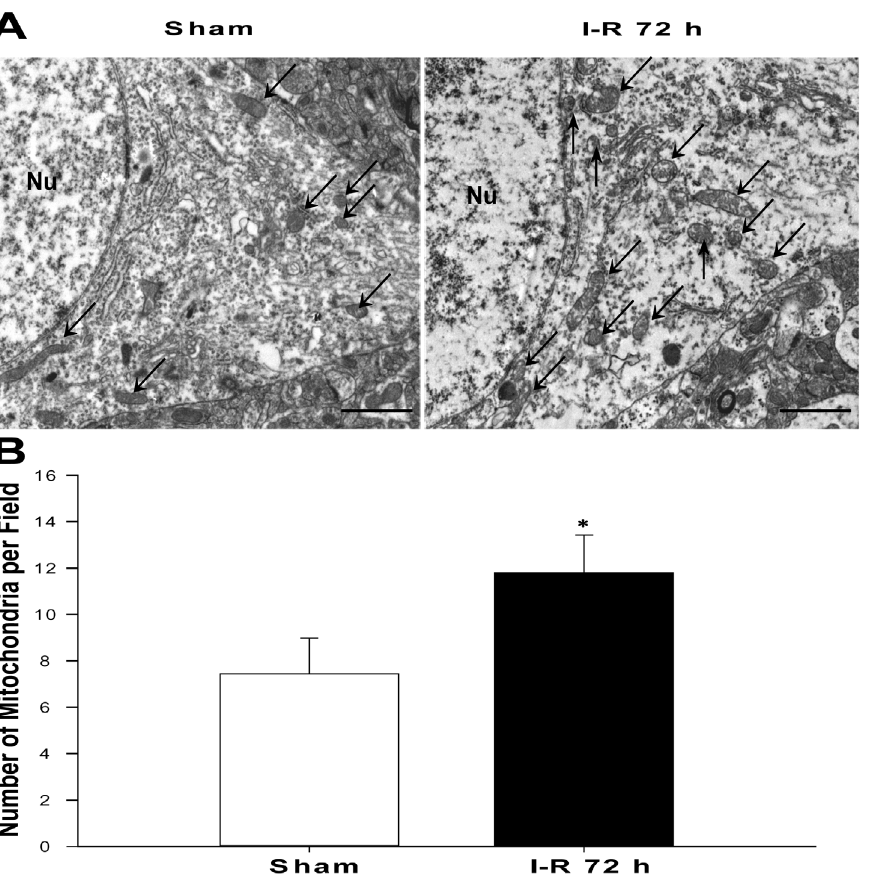
Figure 2. Change in the number of mitochondria after I-R. (A) Transmission electron microscopy images of a section from the cortex showing the nucleus (Nu) surrounded by relatively uniform and compact mitochondria (arrowheads). Scale bars: 2 m m. (B) A histogram quantifying the number of mitochondria in the cortical cells. Magnification of the brain sections, 8200x. *P , 0.05 versus the sham group.